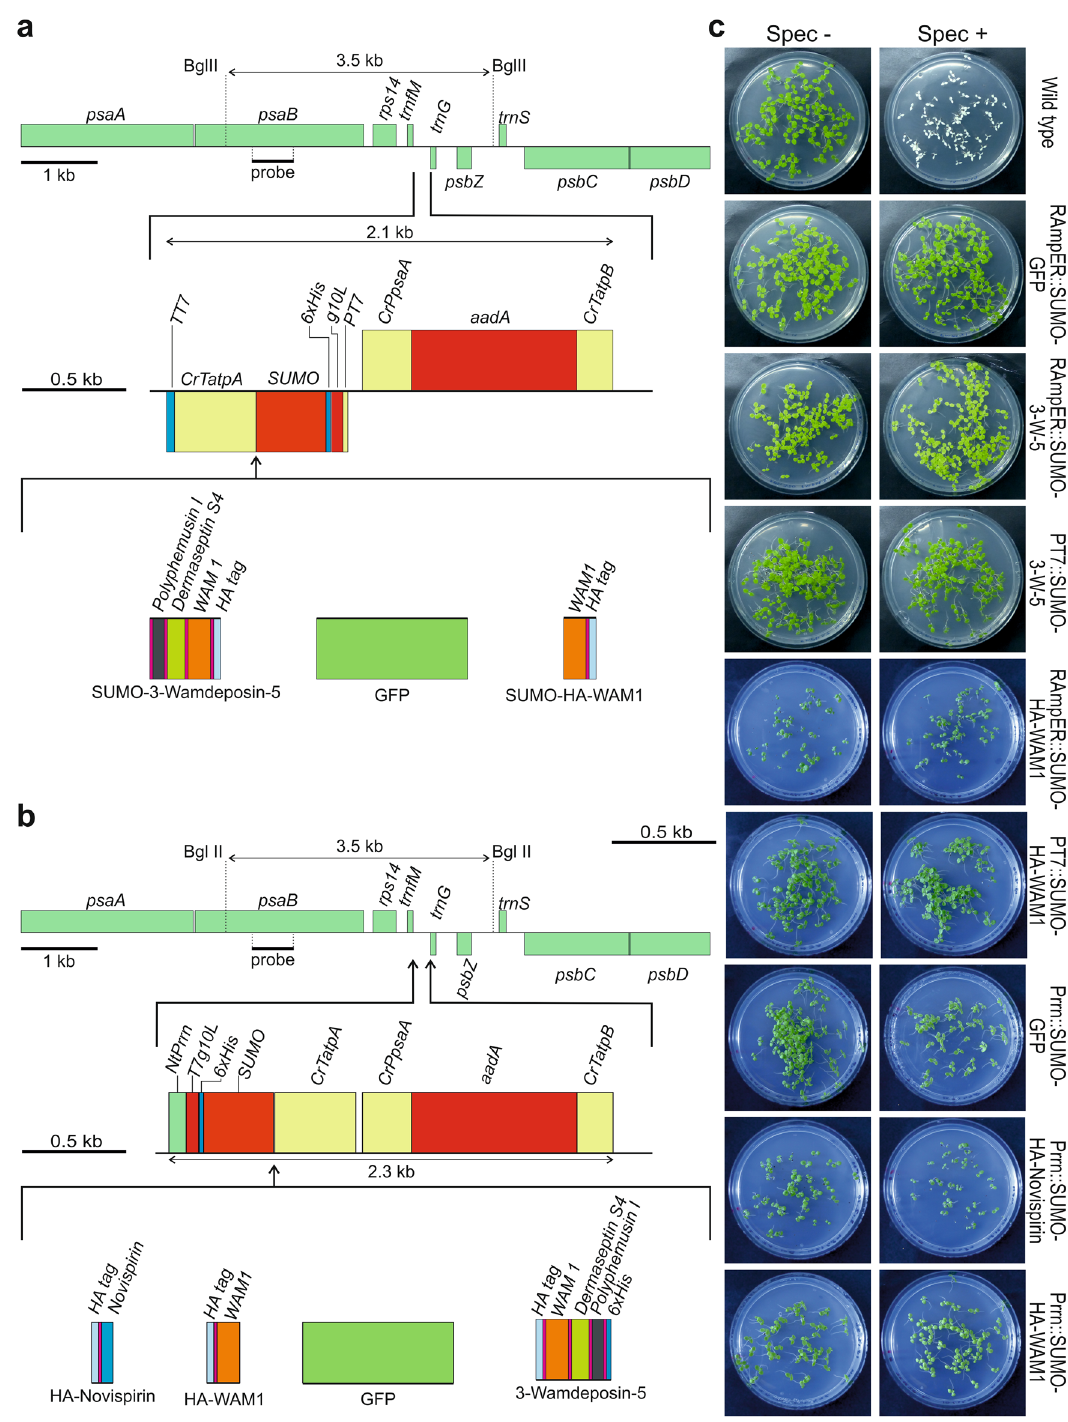
Fig. 5 | Transplastomic expression of AMPs and fAMPs as SUMO fusions. a Physical maps of constructs for the expression of 6xHis-SUMO fusions under the control of the T7 RNA polymerase promoter ( PT7 ). For information on con- struct design and the expression elements used, see Figs. 1a and 3a. b Physical maps of constructs for the expression of 6xHis-SUMO fusions under the control of the plastid rRNA operon promoter (Prrn) and the gene10 leader ( T7g10L ) from phage T7. Note that the transgenes under the control of PT7 have the opposite